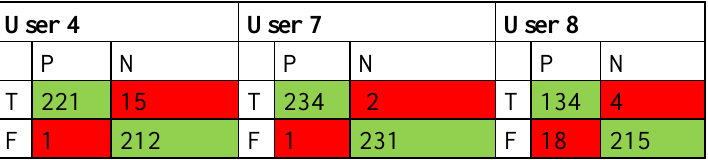
Table 12. SCR confusion matrix for Stroop test I.